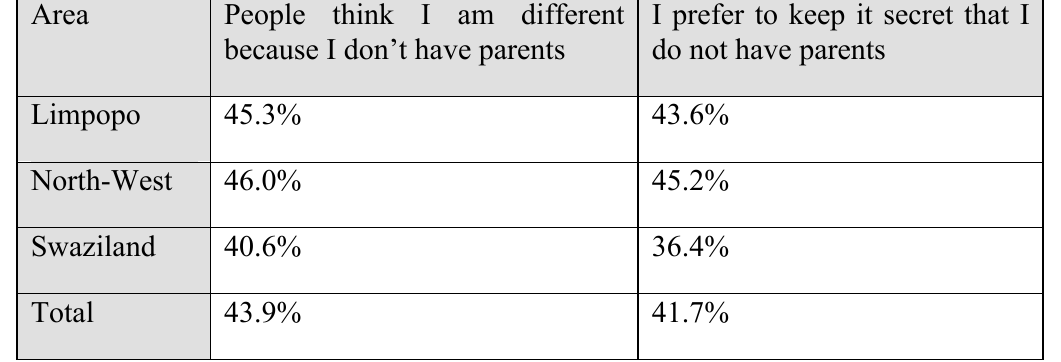
Table 10. Orphans’ responses on their experience of stigmatisation